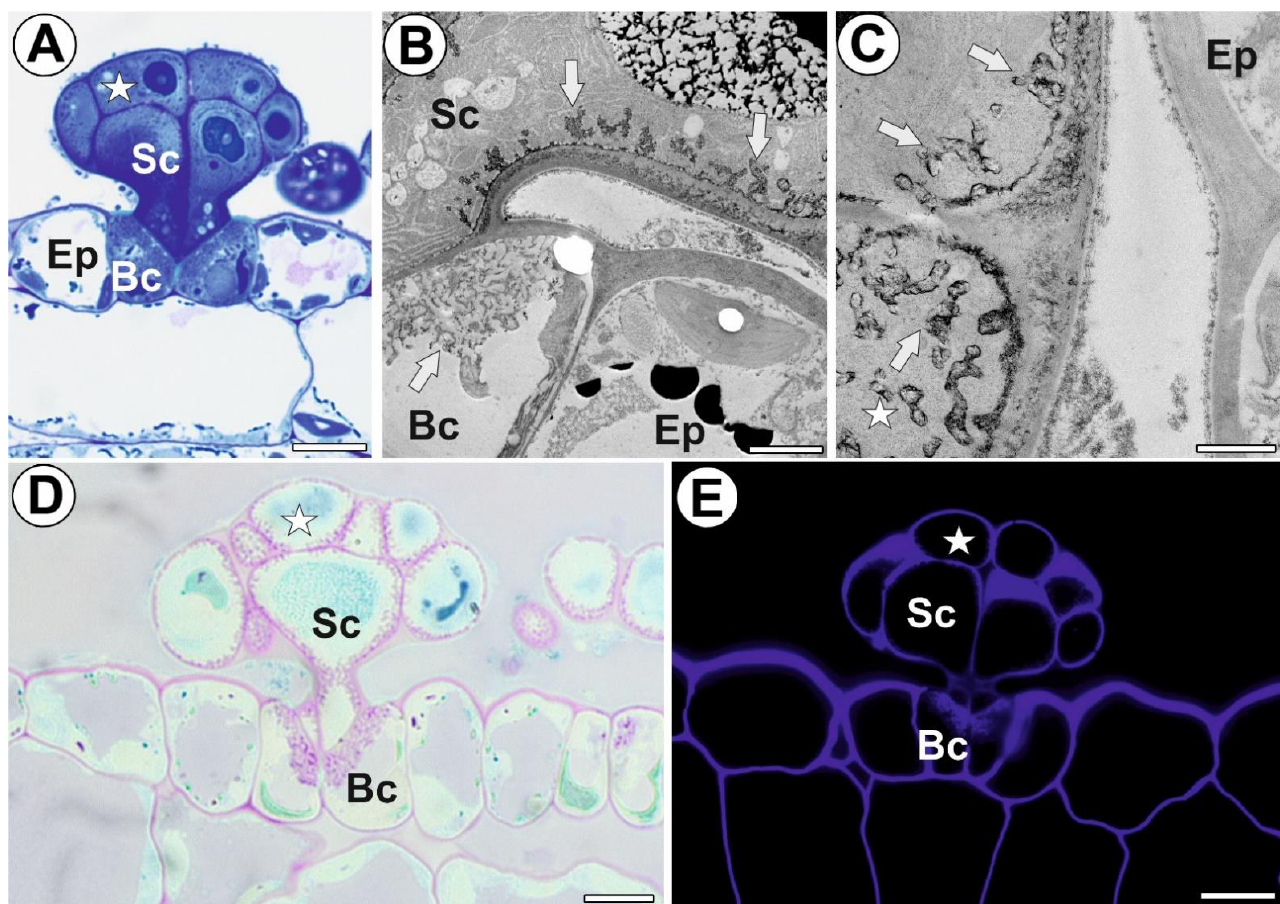
Figure 1. Structure of the digestive gland of A.vesiculosa . ( A ) A semithin section of the digestive gland; secretory cell (star), stalk cell (Sc), basal cell (Bc), ordinary epidermal cell (Ep), bar 10 µm. ( B , C ) Ultrastructure of digestive glands, localization of cell wall ingrowths (white arrow); head cell (star), stalk cell (Sc), basal cell (Bc), ordinary epidermal cell (Ep), bar 1 µm. ( D ) Digestive gland, PAS reaction; head cell (star), stalk cell (Sc), basal cell (Bc), bar 10 µm. ( E ) Digestive gland, calcofluor white staining; head cell (star), stalk cell (Sc), basal cell (Bc), bar 10 µm . Table 1. Summary of antibody labeling of selected cell walls in Aldrovanda vesiculosa digestive gland. Epitope/ Type of Cell